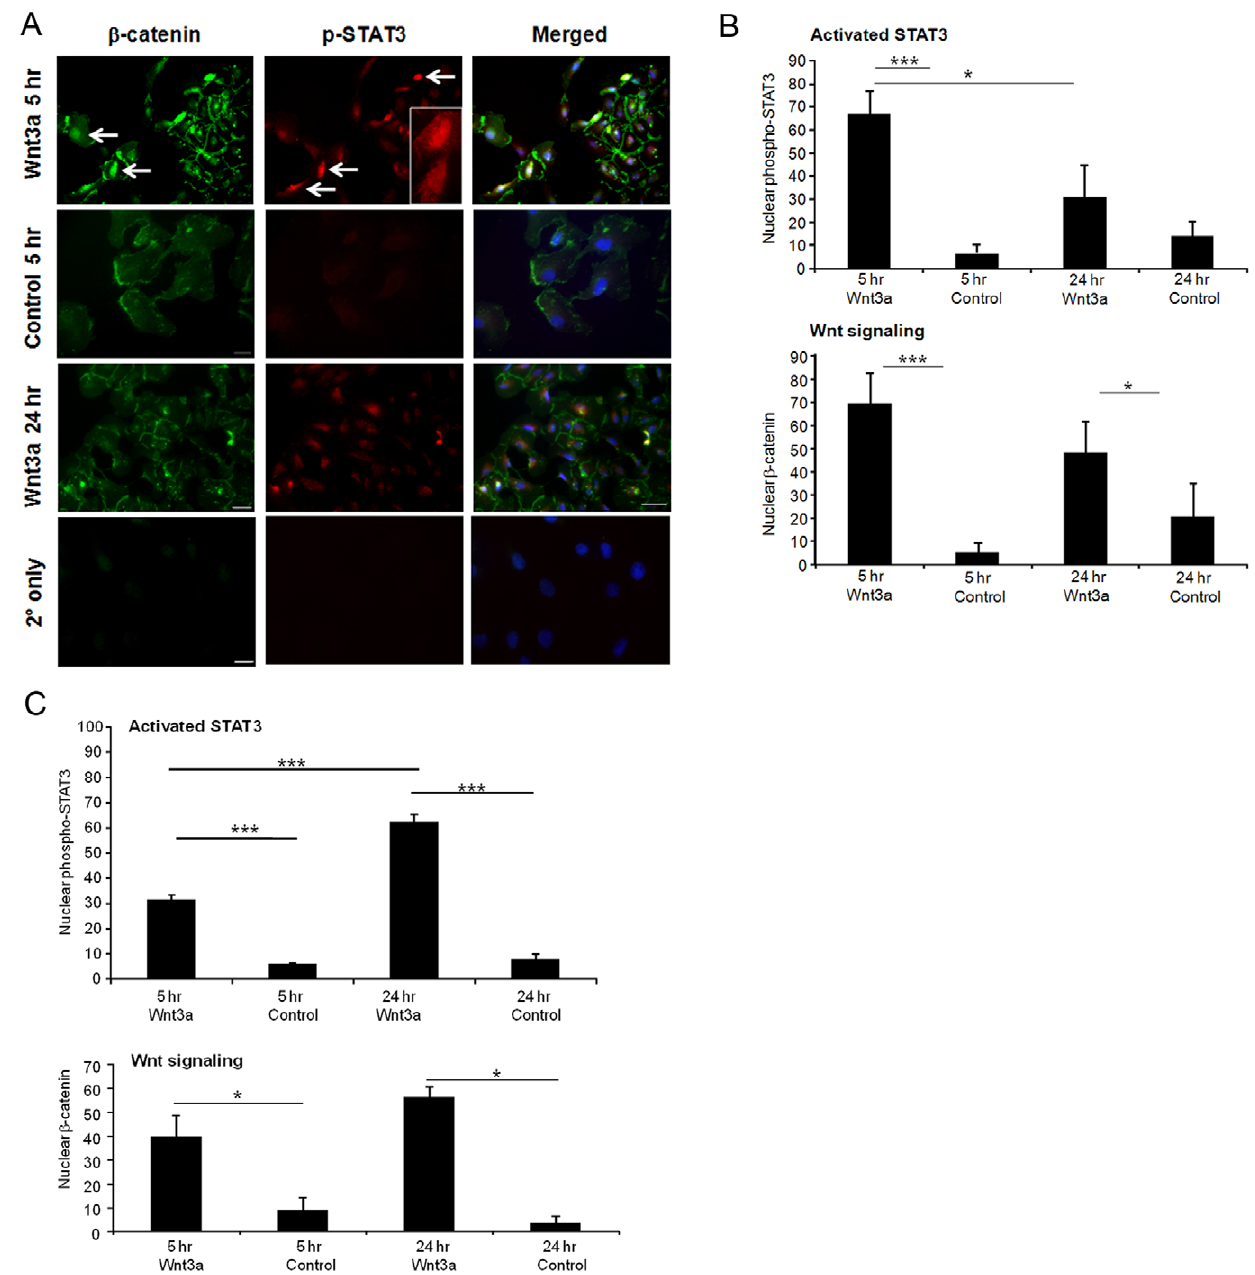
Figure 3. Wnt3a activated STAT3 in ARPE-19 cells. (A) Nuclear localization of phospho-STAT3 is used as a marker of activated STAT3. Incubation of sub-confluent cells with Wnt3a induced transient translocation of pSTAT3 (red) into the nucleus (arrows) after 5 hr incubation, but not after 24 hr. The inset shows a higher magnification. Overlap of pSTAT3 with the DNA dye DAPI (blue) was used to demonstrate nuclear localization. Incubation of cells with control media showed only cytoplasmic phospho-STAT3. Nuclear b -catenin was used as an endogenous marker of Wnt signaling and is observed at both 5 and 24 hr time-points. The absence of primary antibody control (2 u only) demonstrates specificity of the immunostaining (see also isotype control antibody in Figure S4). Scale bar in the top 3 rows represents 50 m M; bottom row, 20 m M. (B) Quantification of nuclear phospho-STAT3 and nuclear b -catenin in cells treated with Wnt3a or control for 5 and 24 hr. The percent of total cells with nuclear proteins is shown (n=3, *p , 0.05; ***p , 0.001). Wnt3a transiently increased the number of cells with nuclear phospho-STAT3, indicating that Wnt3a activates the STAT3 pathway. (C) Quantification of nuclear pSTAT3 and nuclear b -catenin in cells that were cultured as a polarized post-confluent monolayer, and treated with Wnt3a or control media. Wnt3a induced significant increases in pSTAT3 nuclear localization at both 5 and 24 hrs of treatment (n=3, *p , 0.01). The percent of total cells with nuclear proteins is shown. doi:10.1371/journal.pone.0046892.g003 induces various pro-survival pathways [11,13,14,38,39]. However, migration [19]. Our results indicated that Wnt3a caused a large nuclear b -catenin has also been suggested to be a component of increase in cellular viability (using an assay that measured proliferative retinal disease by inducing RPE proliferation and mitochondrial function) but only mild increases in proliferation,